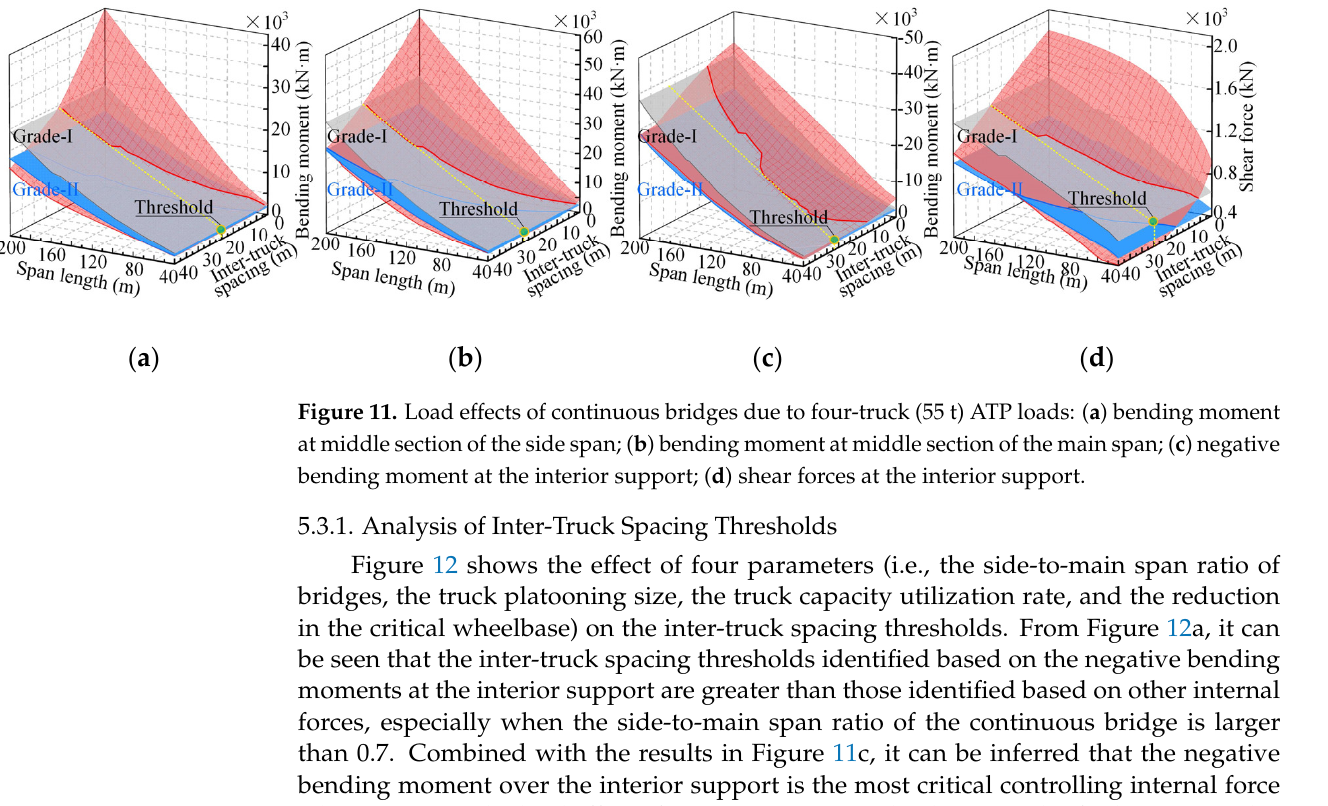
Table 2. Identified mass limits for platooning trucks crossing simply supported bridges.